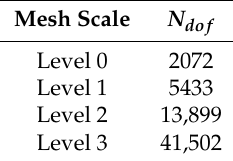
Table 1. These four meshes are utilized consistently in [7,11]. The N dof are calculated for the ( P 3 , P 2 ) Taylor–Hood finite elements.